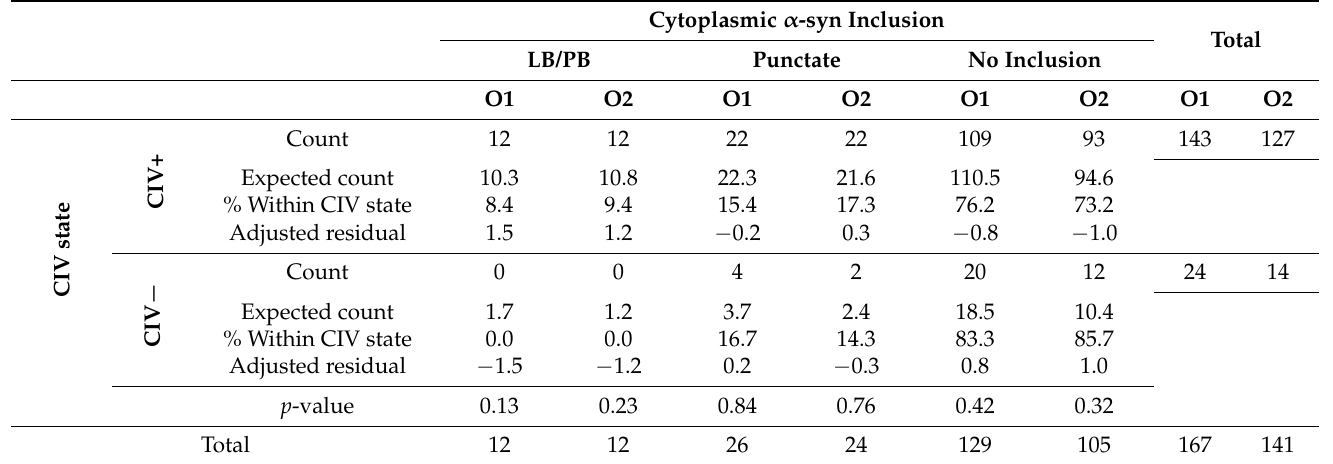
Table 3. A 2 × 3 contingency table of CIV state (negative/positive) by α -syn inclusion (LB or PB/punctate inclusions/no